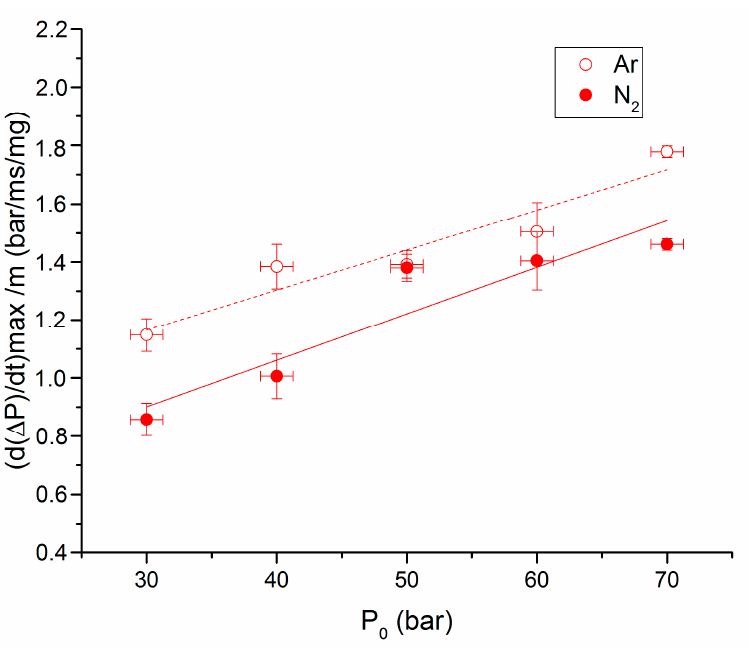
Figure 10. Overpressure vs. P0 for the 90-10 propellant under N 2 and Ar.